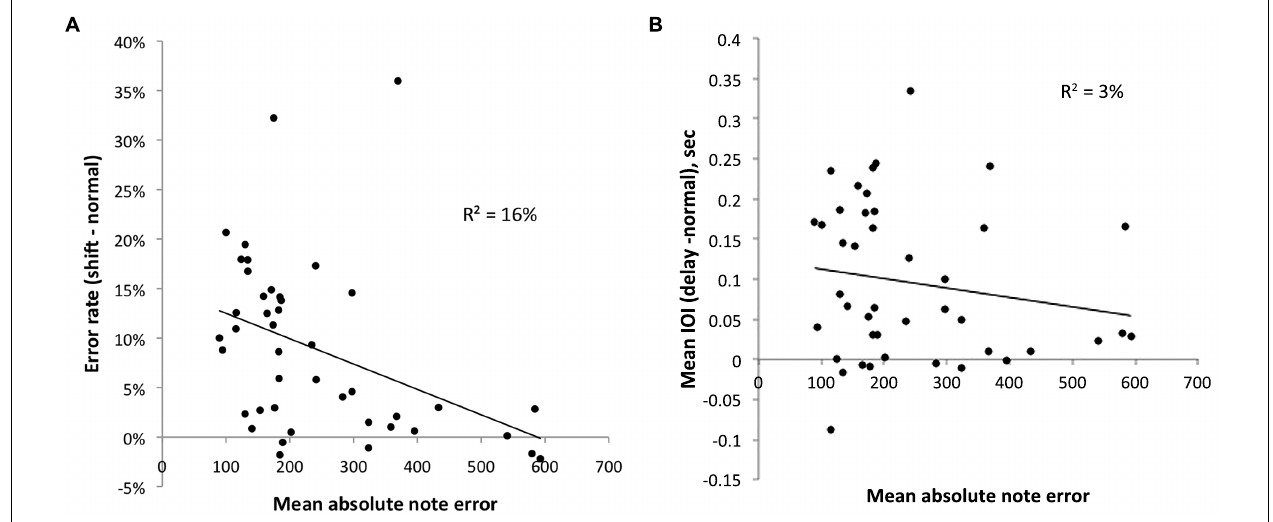
FIGURE 7 | Relationship between degree of mistuning for individual sung pitches (X-axis), and the disruptive effects of altered auditory feedback (Y-axis). Different panels incorporateY-axes that represent the disruptive effects of serially shifted feedback on production errors (A) and the disruptive effect of asynchronous feedback on production rate (B)